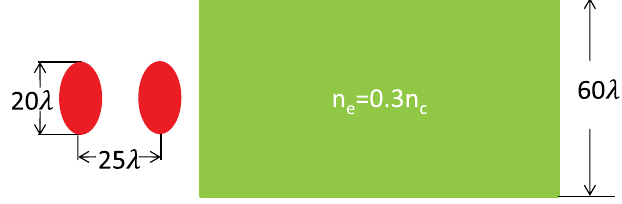
FIG. 1. Proposed scheme. The distance between the two laser pulses is 25 λ .